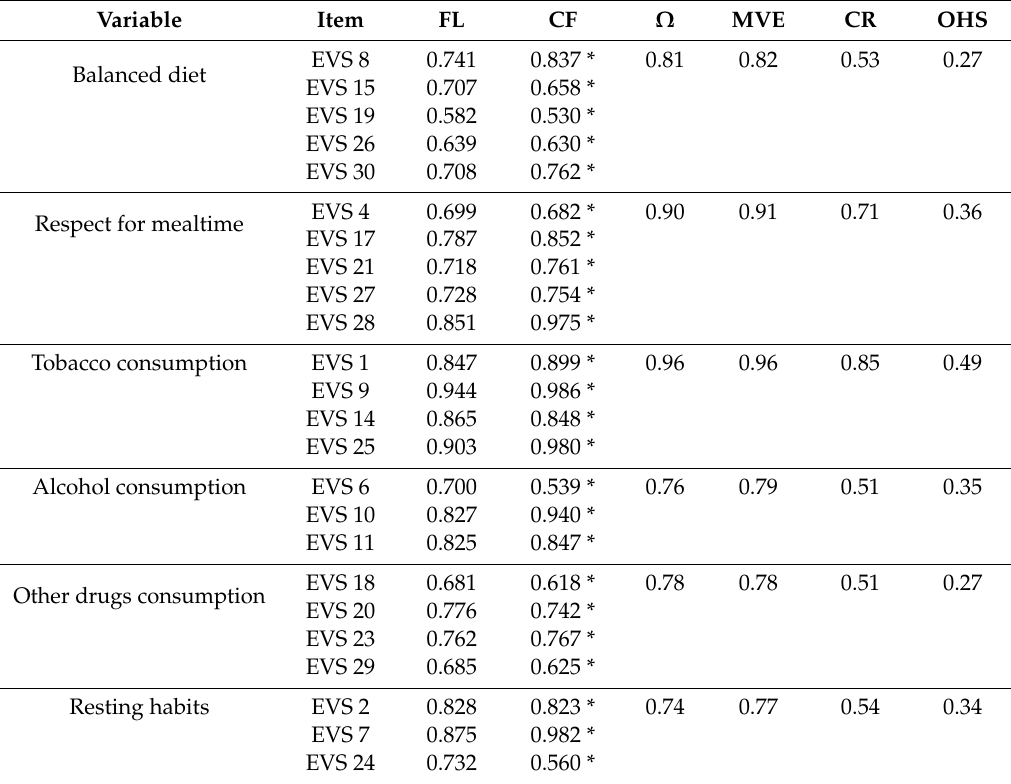
Table 1. Internal consistency values of EVS